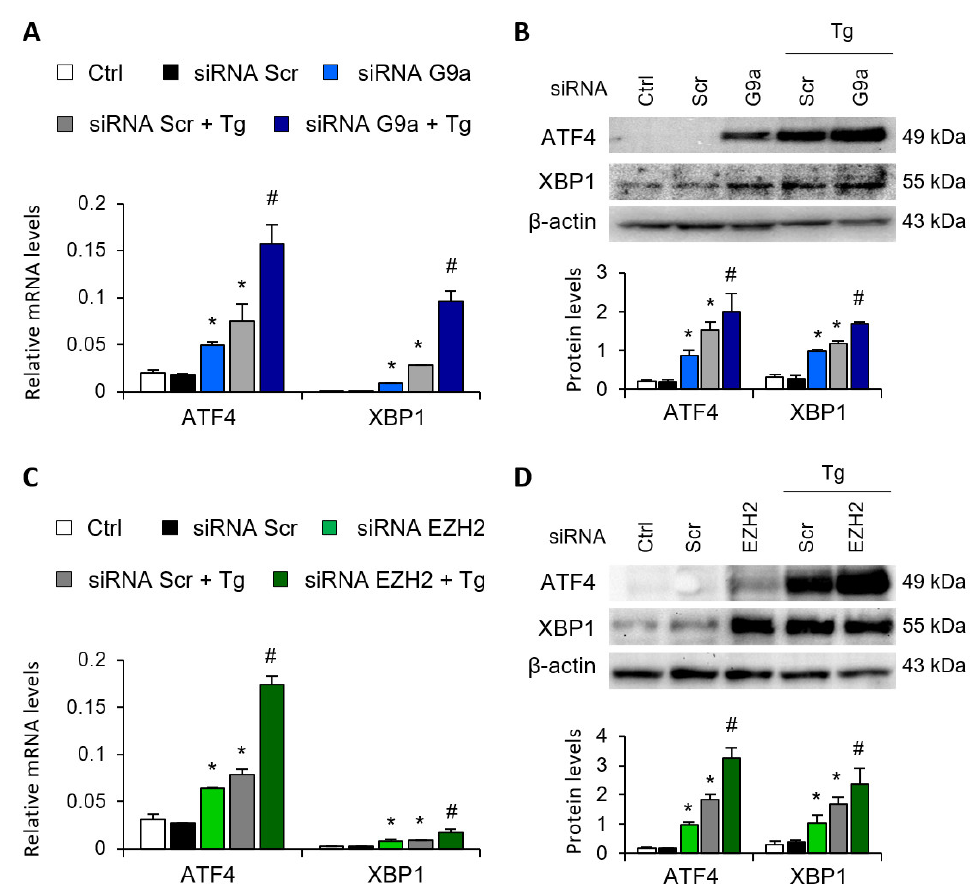
Figure 3. G9a and EZH2 disruption favors ATF4 and XBP1 upregulation in renal tubular epithelial cells. HK-2 cells were transfected with specific G9a siRNA ( A , B ), EZH2 siRNA ( C , D ) or nonspecific scramble (Scr) siRNA (80 nM) for 48 h. Tg (4 μM) was added in the final 24 h to induce UPR activation. Gene expression ( A , C ) and protein ( B , D ) levels of ATF4 and XBP1 were assayed by quantitative RT-PCR and Western blotting, respectively. GAPDH and β-actin were used as controls. Results are expressed as the mean ± SEM of three independent experiments. * p < 0.05 vs. siRNA Scr; # p < 0.05 vs. siRNA Scr + Tg (cells transfected with siRNA Scr and treated with Tg).